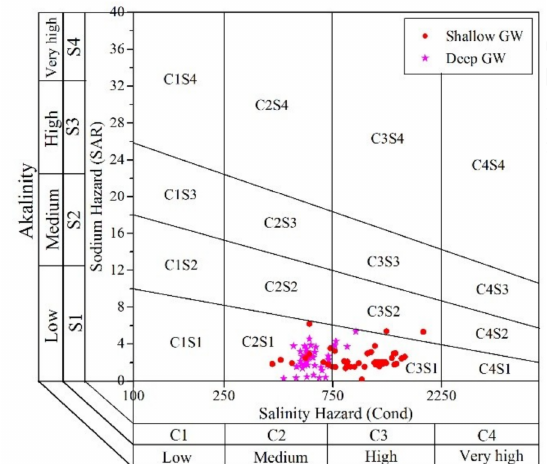
Figure 11. USSL diagram for groundwater in shallow and deep aquifers.